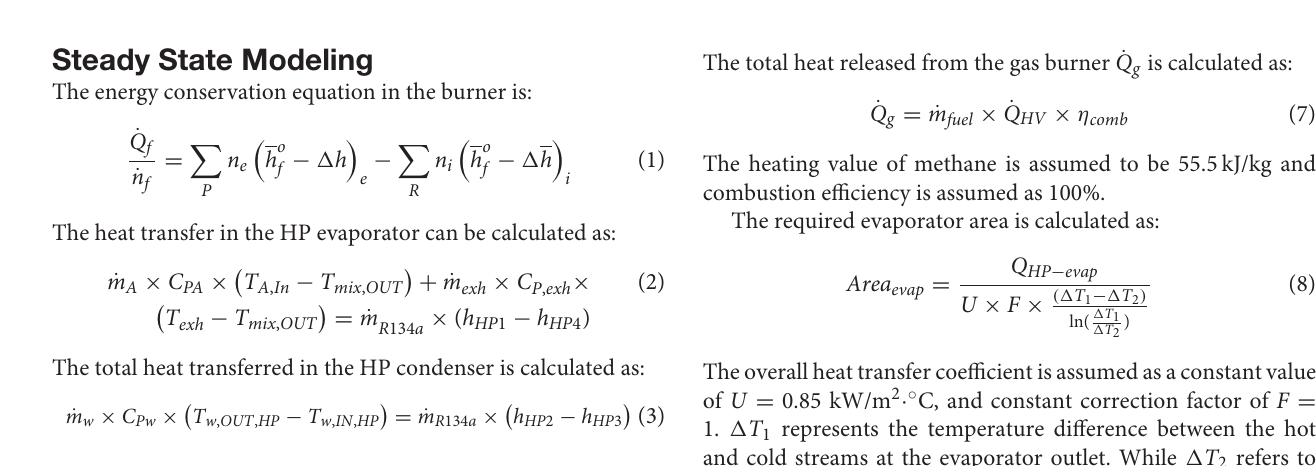
FIGURE 2 | T-s diagrams for two subcycles. (A) T-s diagram for HP cycle (using R134a). (B) T-s diagram for ORC cycle (using